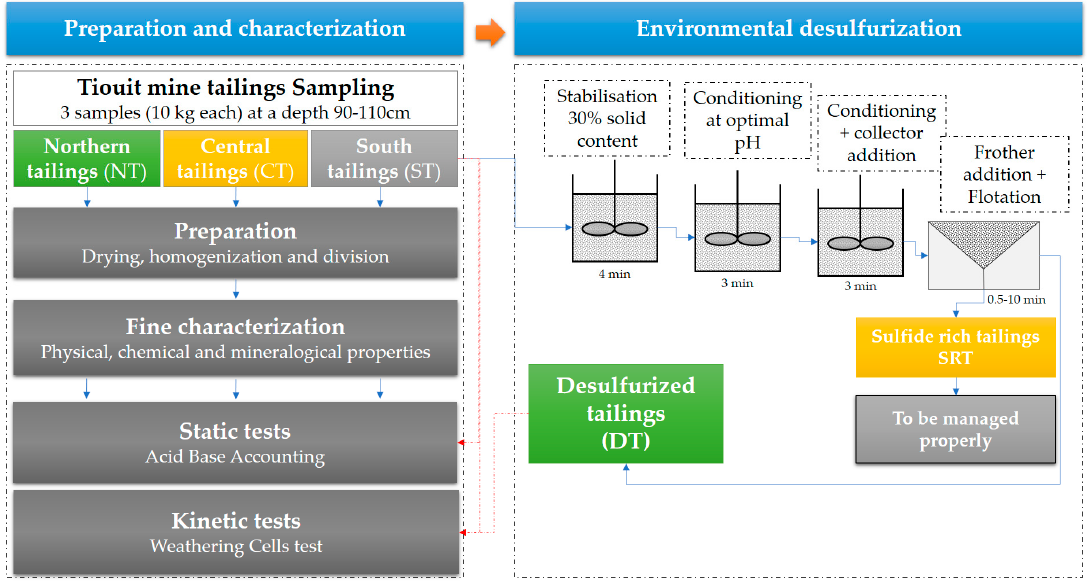
Figure 2. Schematic illustration of the methodology followed in this study.